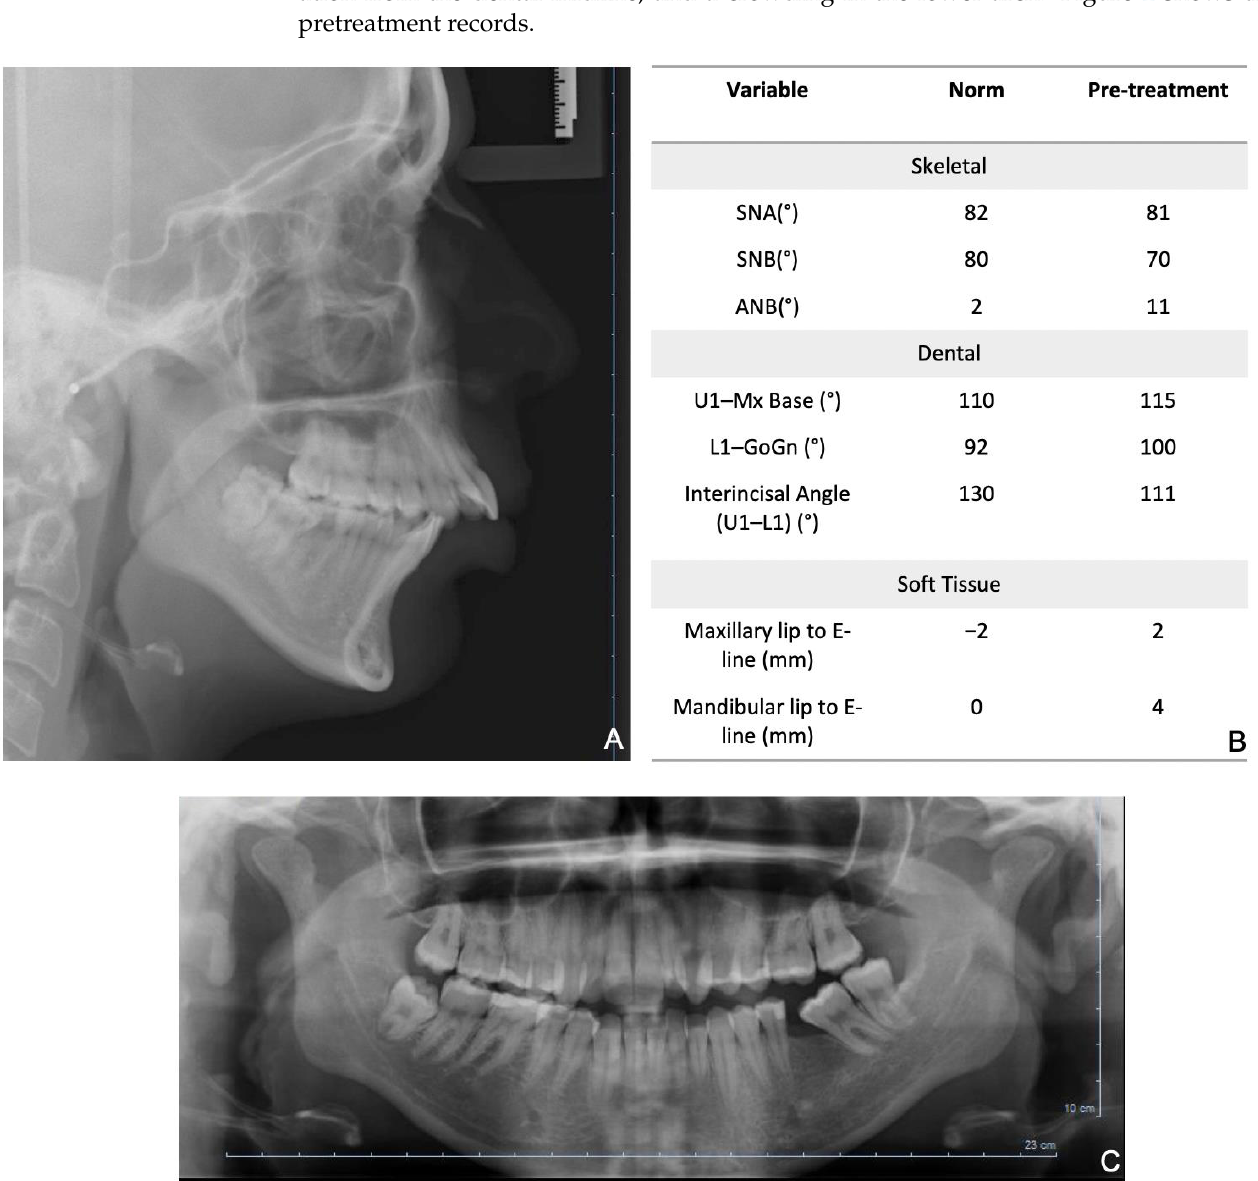
Figure 1. Photography of the custom-manufactured dental-anchored distractor.